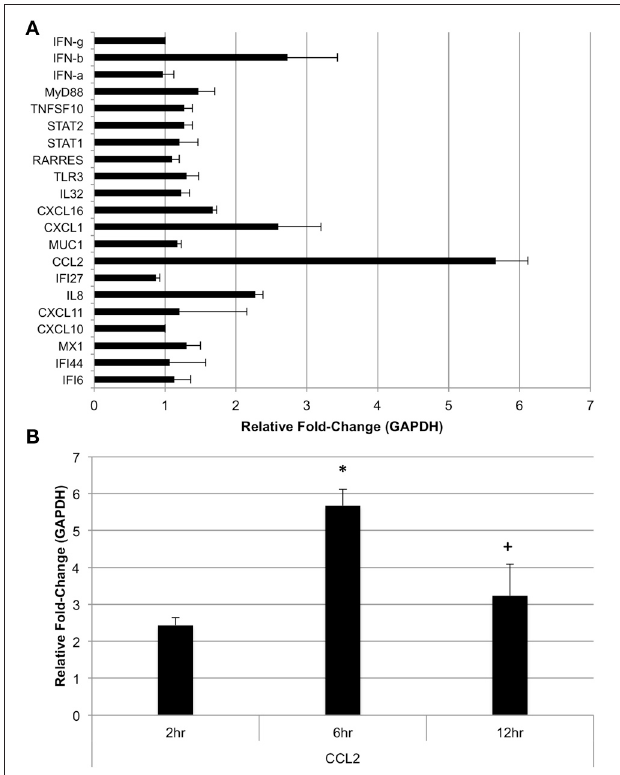
FIGURE 8 | Expression of selected genes in human bronchial epithelial cells post- Alternaria alternata spore challenge. (A) BEAS-2B cells were challenged with 1 × 10 5 A. alternata spores and cells were harvested for RNA extraction and qRT-PCR 6h later. (B) CCL2 was assayed by qRT-PCR in cells harvested at 6 and 12h post-spore challenge. ∗ p ≤ 0 . 01 vs. control; + p ≤ 0 . 05 vs. 6h.